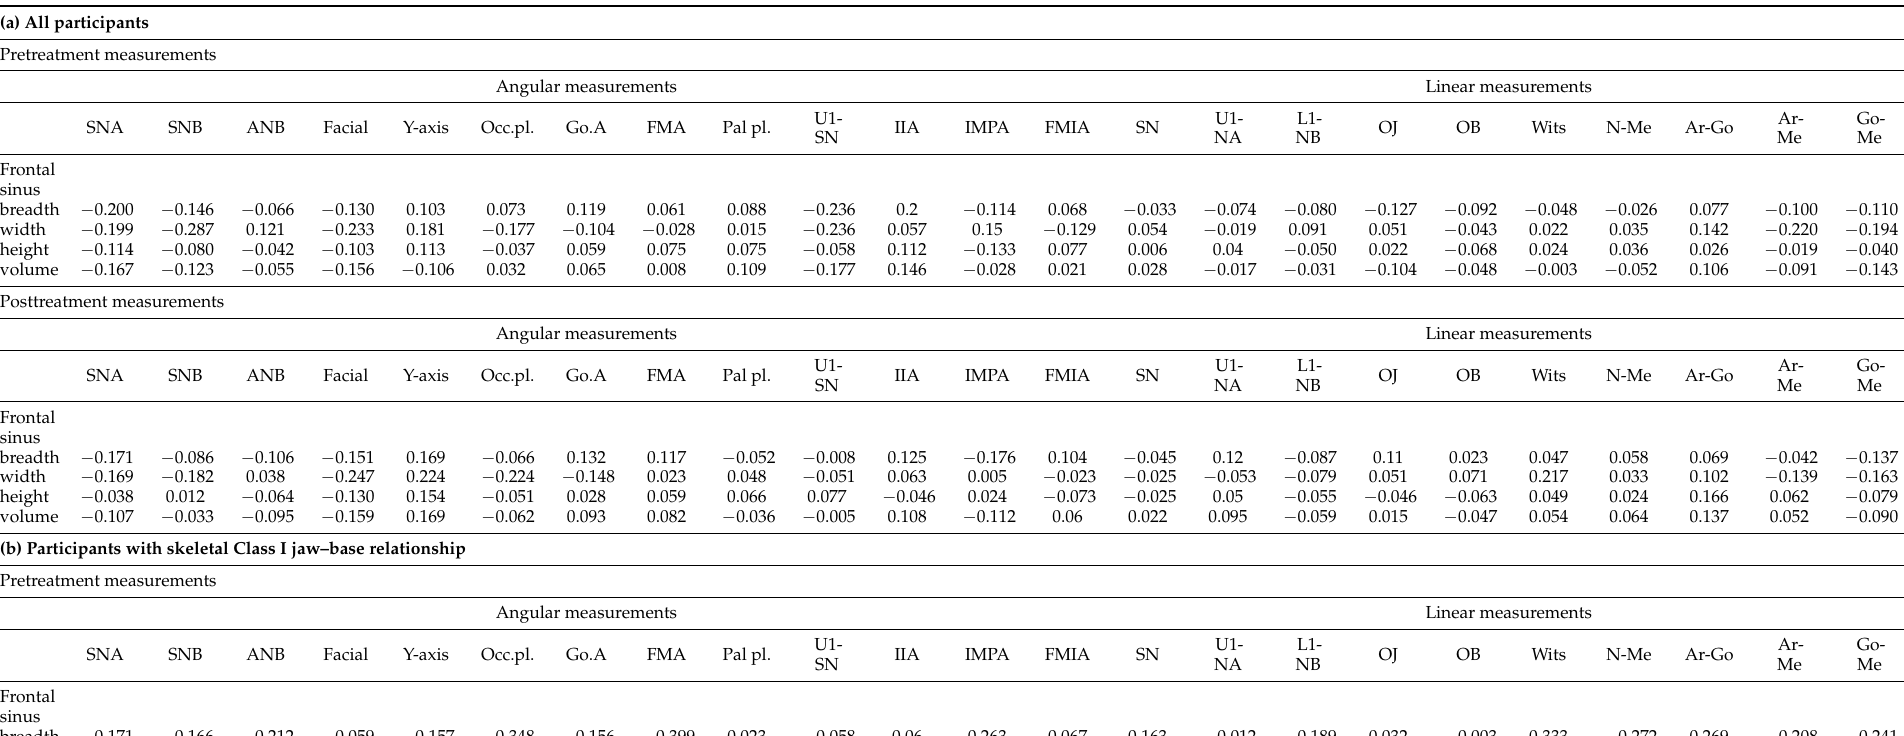
Table 4. Standardized coefficients between the measurement values for the frontal sinus in relation to the cephalometric measurement variables analyzed by single regression analysis. ( a ) All participants, ( b ) participants with skeletal Class I jaw–base relationship, ( c ) participants with skeletal Class II jaw–base relationship, and ( d ) participants with skeletal Class III jaw–base